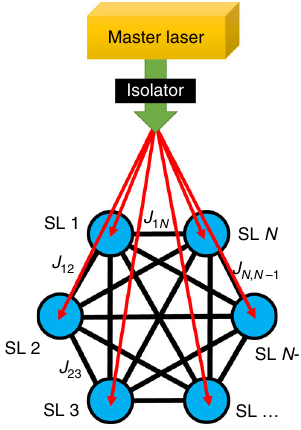
Fig. 1 Injection-locked laser system scheme. N as the number of slave lasers (SLs) denotes the size of the Ising Hamiltonian and the optical interactions pathway between them follow the mutual couplings concept. Master laser (ML) initiates the Ising Hamiltonian with slightly change to its vertical linear polarization